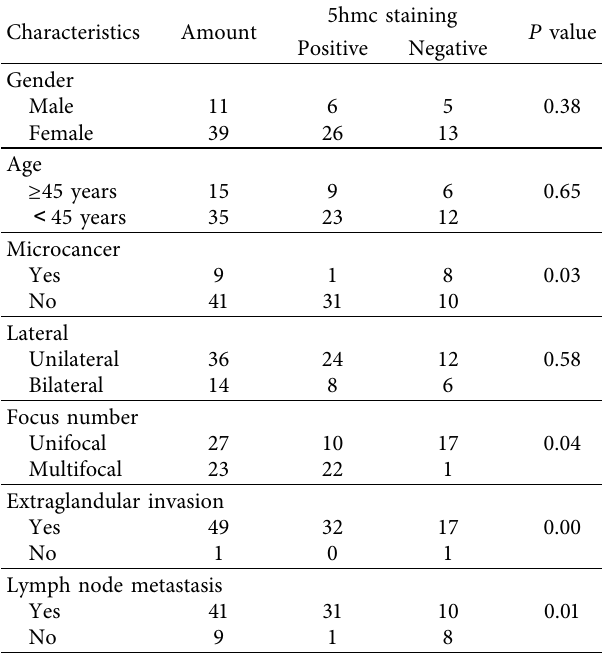
Table 3: Relationship between 5hmc positive and clinicopatho- logical factors in patients with papillary thyroid carcinoma ( n � 50).